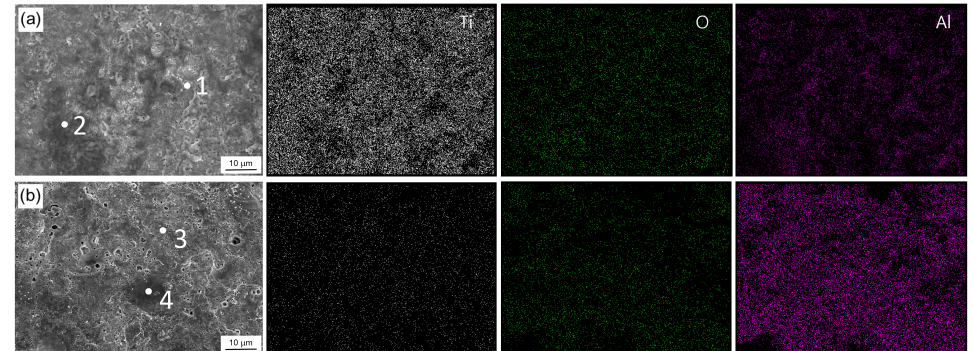
Figure 4. EDS map area of Ti, O, and Al elements on the surface of bath A and bath B samples after PEO for 10 min and 2 min, respectively. Points 1–4 are used for EDS point analysis, and the results are displayed in Table 1.